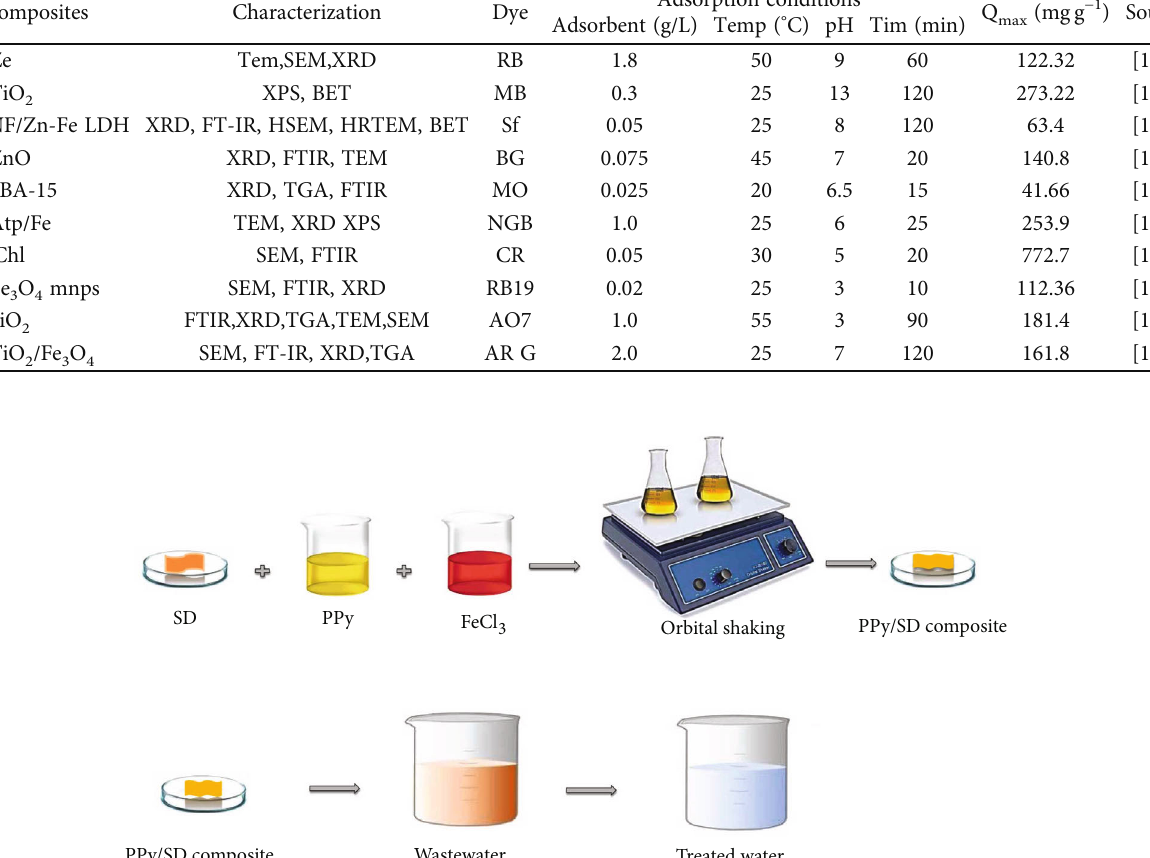
Figure 4: Diagrammatic description of synthesis of PPy/SD